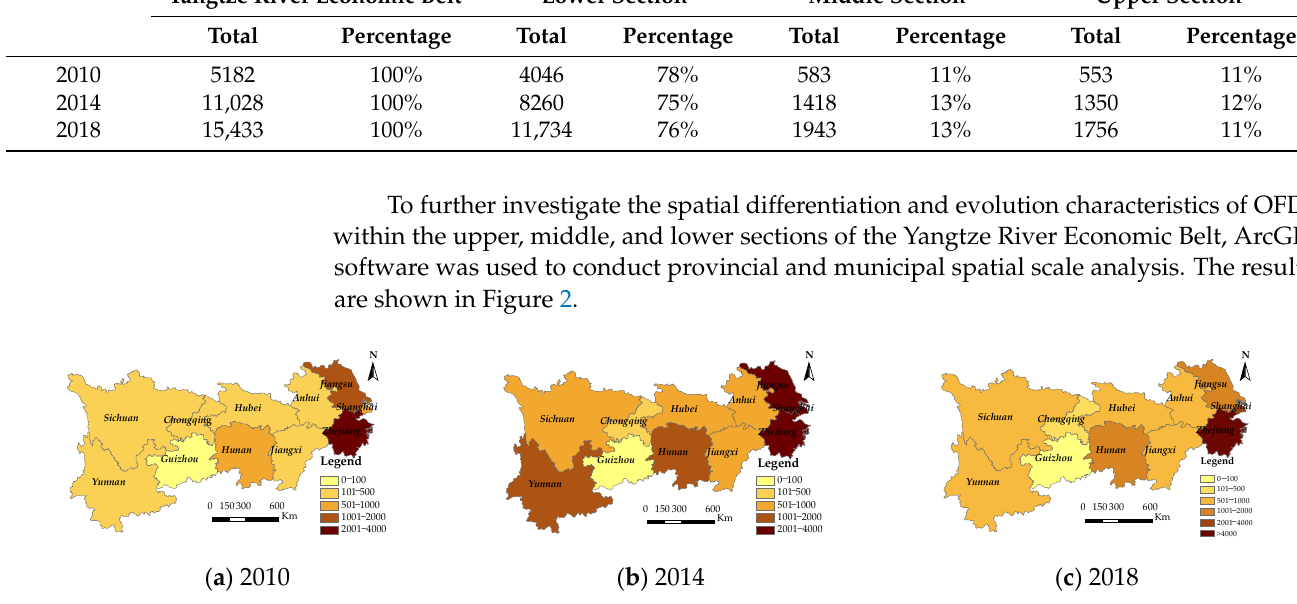
Figure 2. Comparison of the distribution of OFDI enterprises in the Yangtze River Economic Belt (by number).